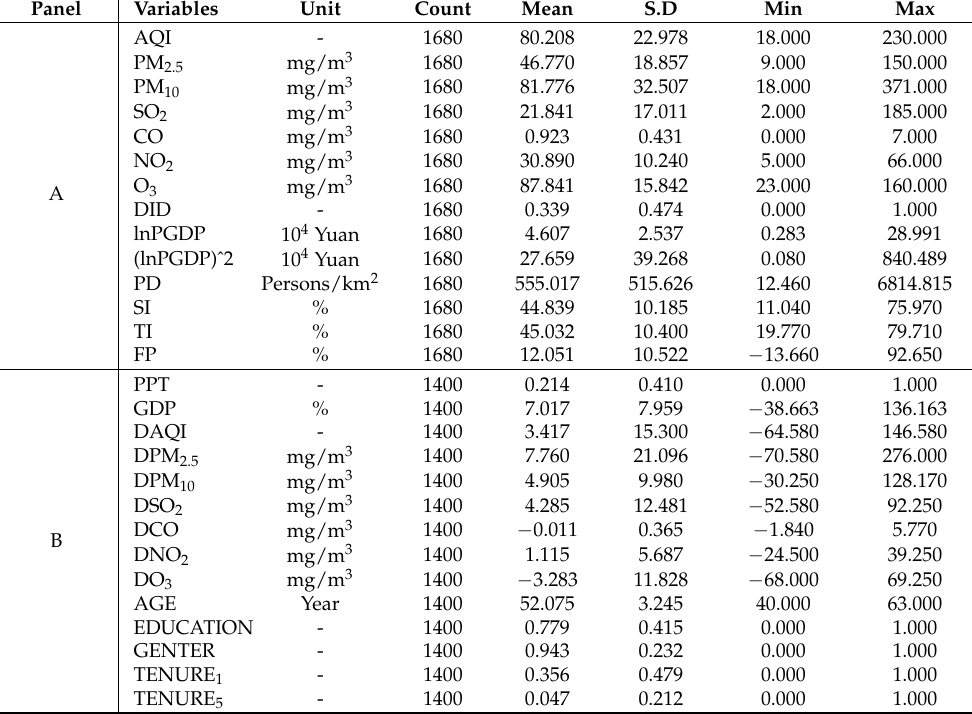
Table 1. Descriptive